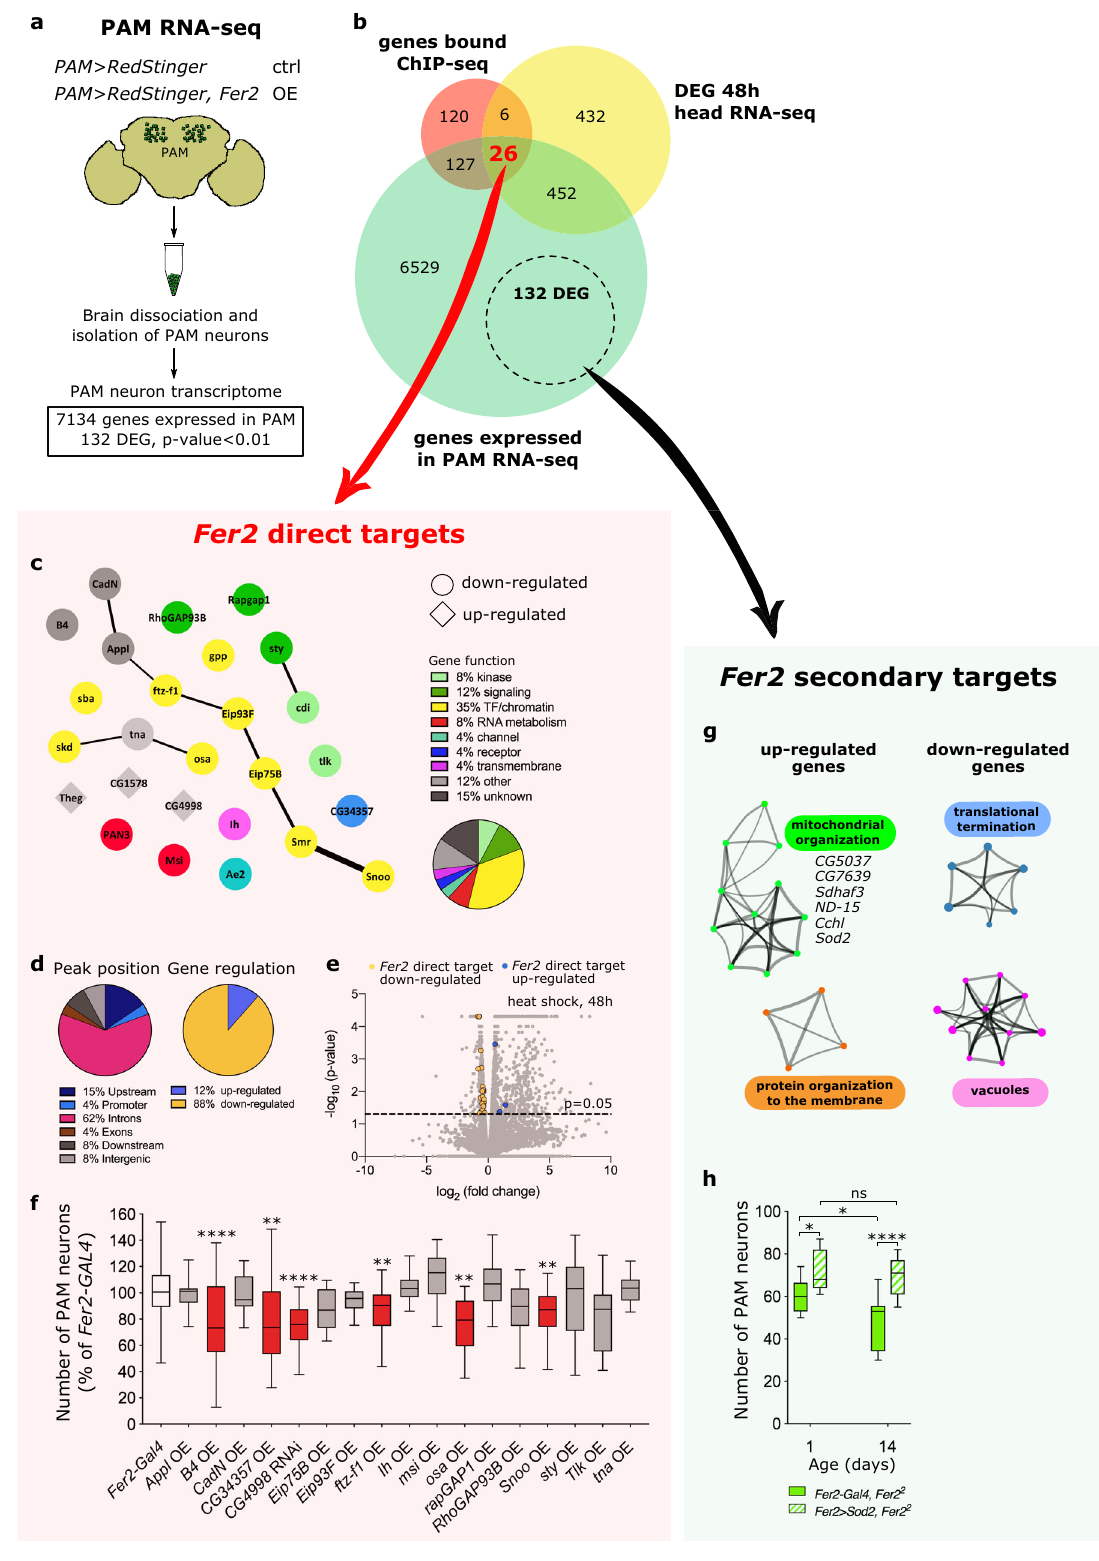
numerous mitochondrial genes, these results demonstrate that Fer2 plays a prominent role in the maintenance of mitochondria. To explore how Fer2 direct targets control a large set of secondary targets, we searched for transcription factor binding sites that are signi fi cantly overrepresented in the promoters of DEGs in PAM RNA-seq. Seven binding motifs were found to